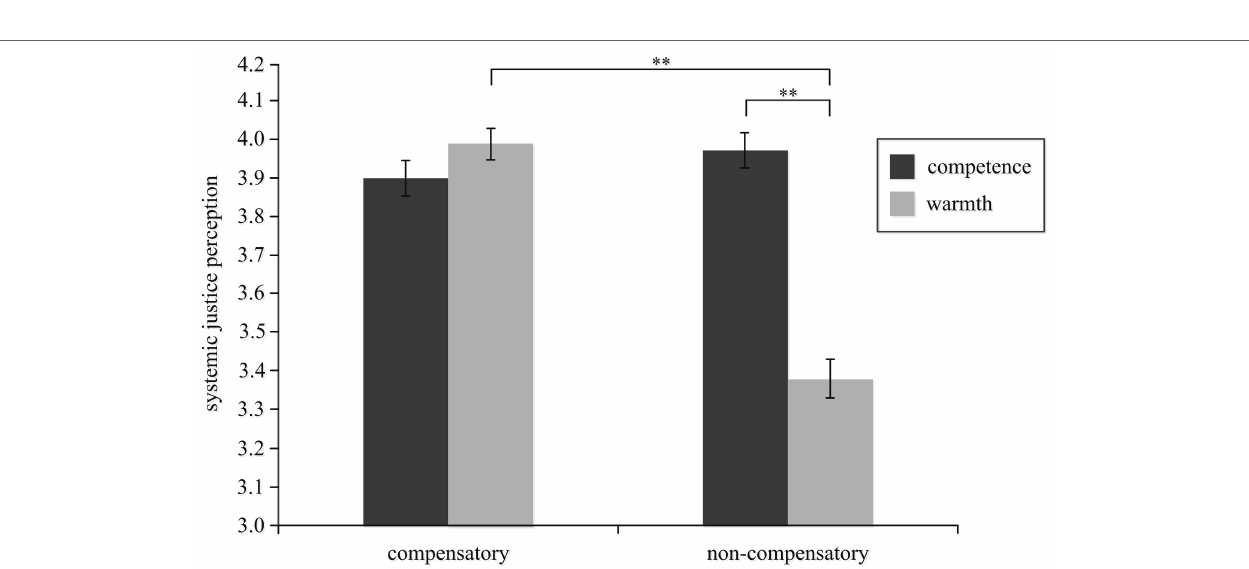
FIGURE 2 | Effects of compensatory stereotypes on different dimensions on systemic justice perception. ** p <